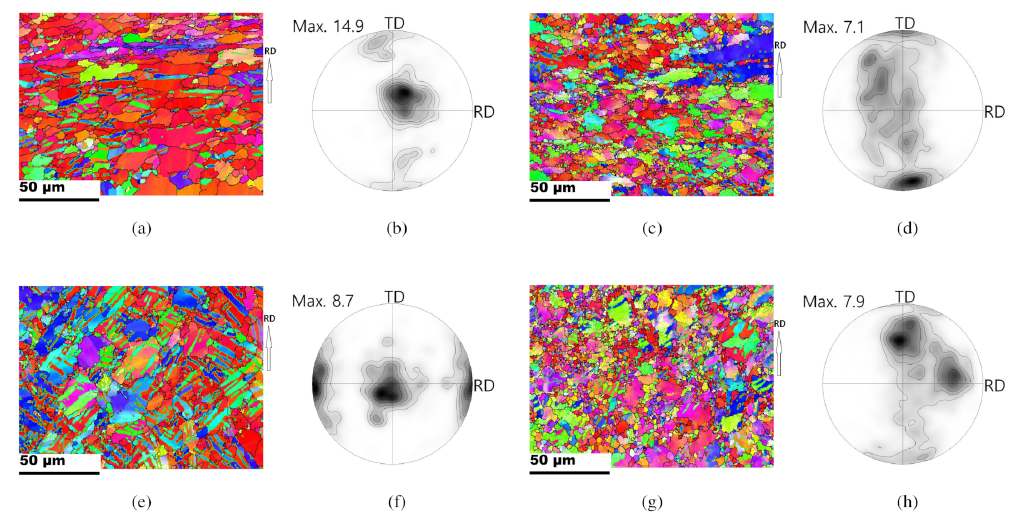
Figure 12. IPF maps and computed 0001 PFs of Part1, and Part3 regions of drawn cups. The punch speed and working temperature were 50mm/min and 225 ◦ C, respectively. Contours: 1, 2, 3, 5, 7, 10, 15, 20. TRC sheets: ( a ) IPF, and ( b ) 0001 PF for Part 1; ( c ) IPF, and ( d ) 0001 PF for Part 3. IC sheets: ( e ) IPF, and ( f ) 0001 PF for Part 1; ( g ) IPF, and ( h ) 0001 PF for Part